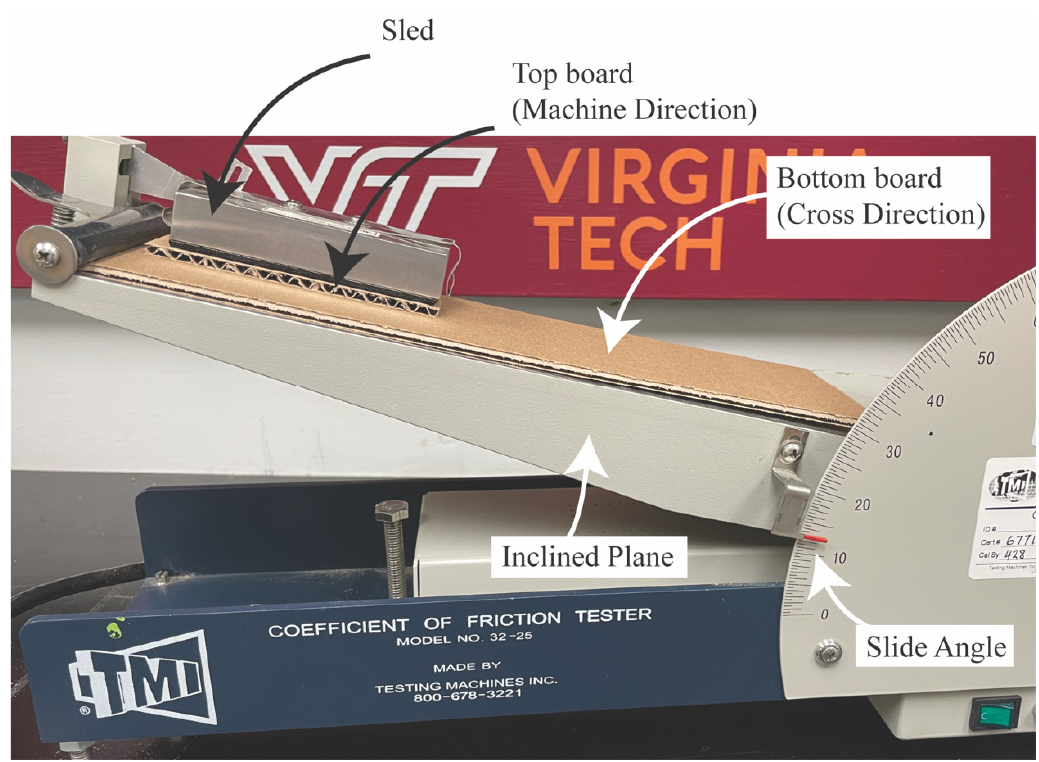
Figure 3. Test setup for the determination of the coefficient of friction of the materials studied following the test standard TAPPI T-815 [46].